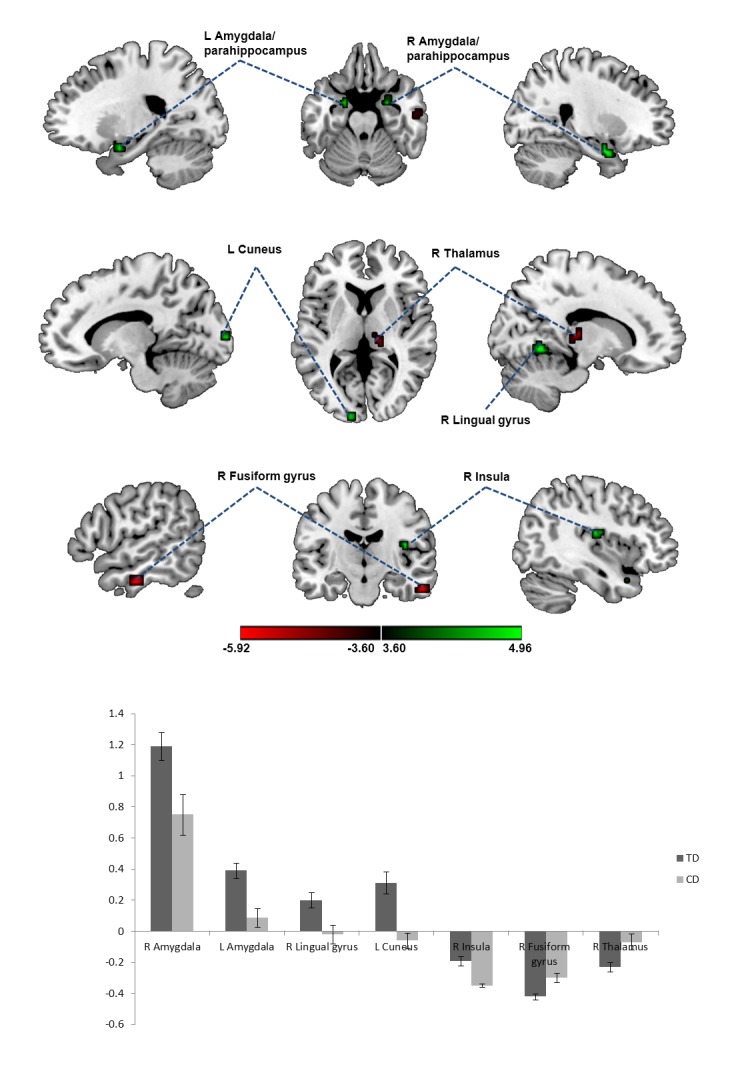
ALFF result in participants with CD compared to TD participants.